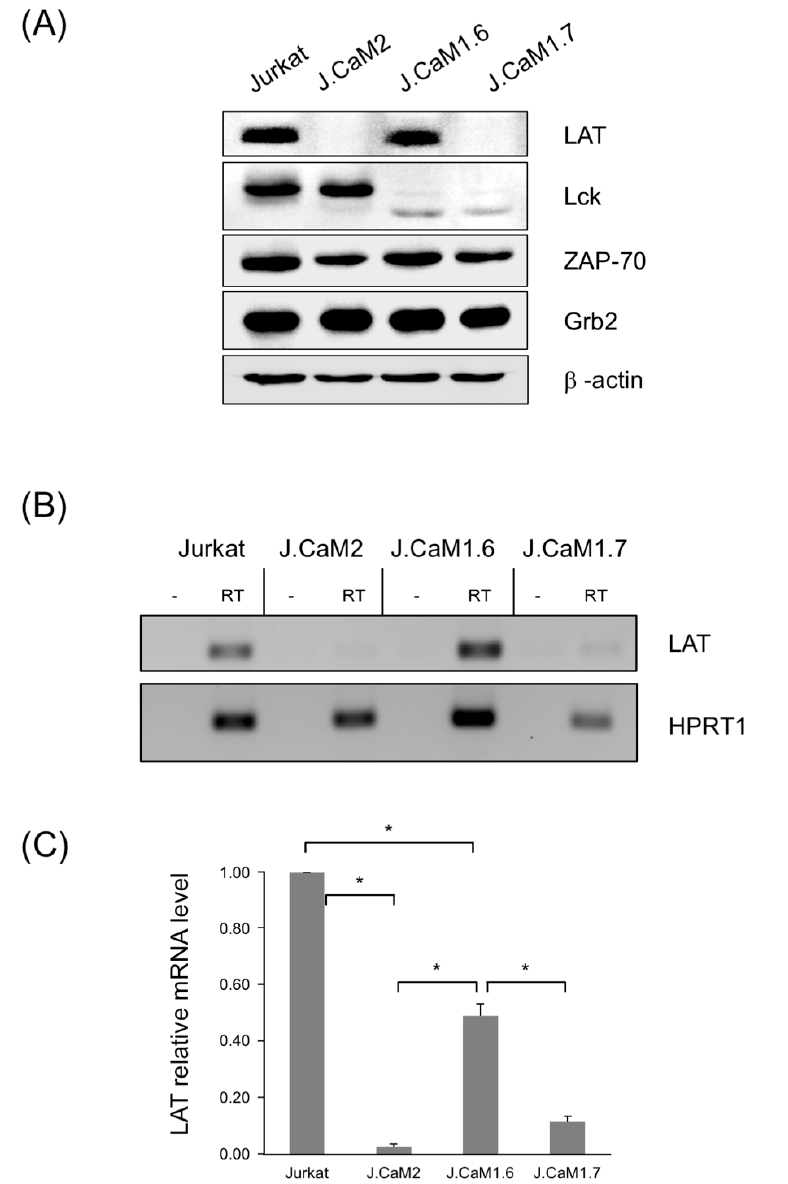
Figure 1. J.CaM1.7 cells are double negative for LAT and Lck expression. ( A ) J.CaM1.7 cells derived from J.CaM1.6 cells were analyzed for LAT, Lck, and β -actin expression by Western blot. Lysates obtained from 10 6 Jurkat, J.CaM2 (LAT deficient), J.CaM1.6 (Lck deficient), and J.CaM1.7 cells were analyzed by Western blot with the indicated specific antibodies. ( B ) RT–PCR analysis of Jurkat, J.CaM2, J.CaM1.6, and J.CaM1.7 cells with specific primers for LAT and HPRT1. For each cell line, a negative control has been included in which RNA was treated without reverse transcriptase. ( C ) LAT relative mRNA levels determined by qPCR analysis in the indicated cell lines and normalized against HPRT1. Values are displayed as means ± s.d. of three independent biological replicates. Asterisks (*) represent statistical significance ( p < 0.001).